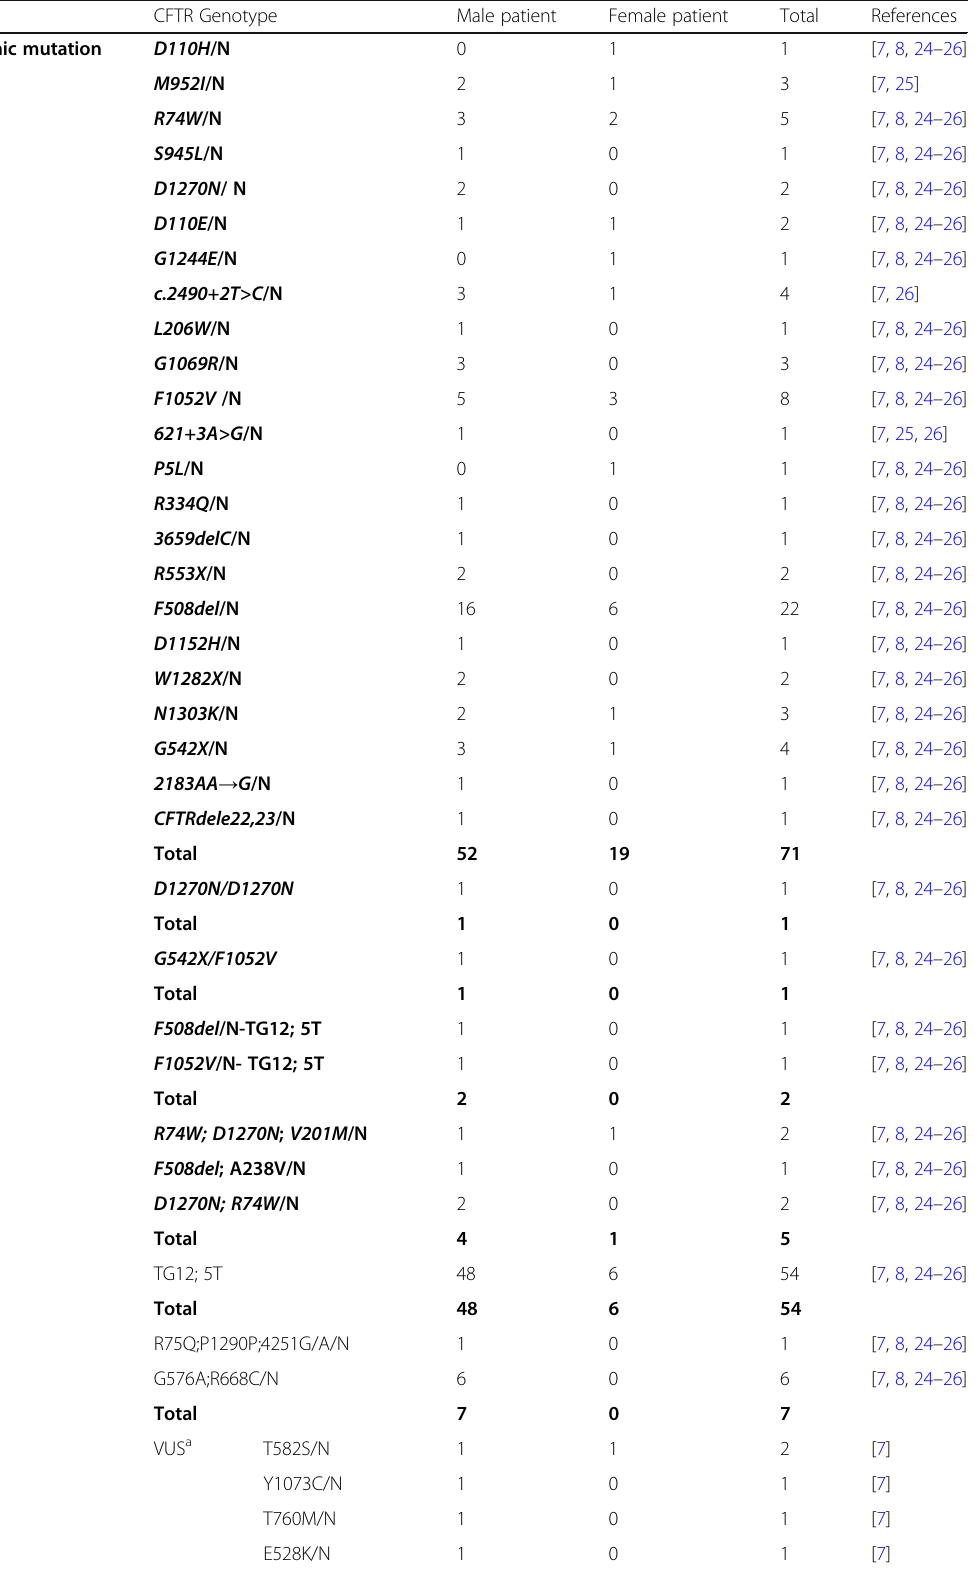
Table 1 CFTR Genotype of the tested eastern Sicilian infertile